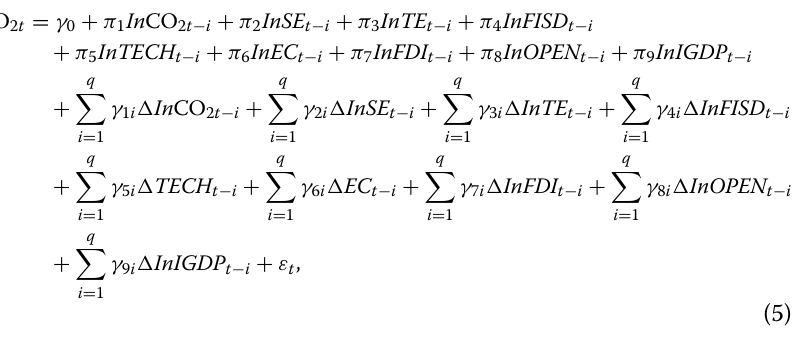
Table 2 presents a summary of the definition of variables and the sources of data.